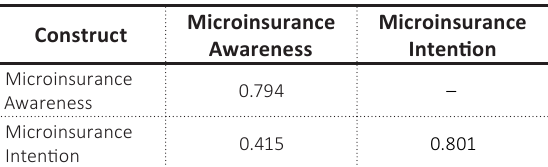
Table 4. Discriminant validity